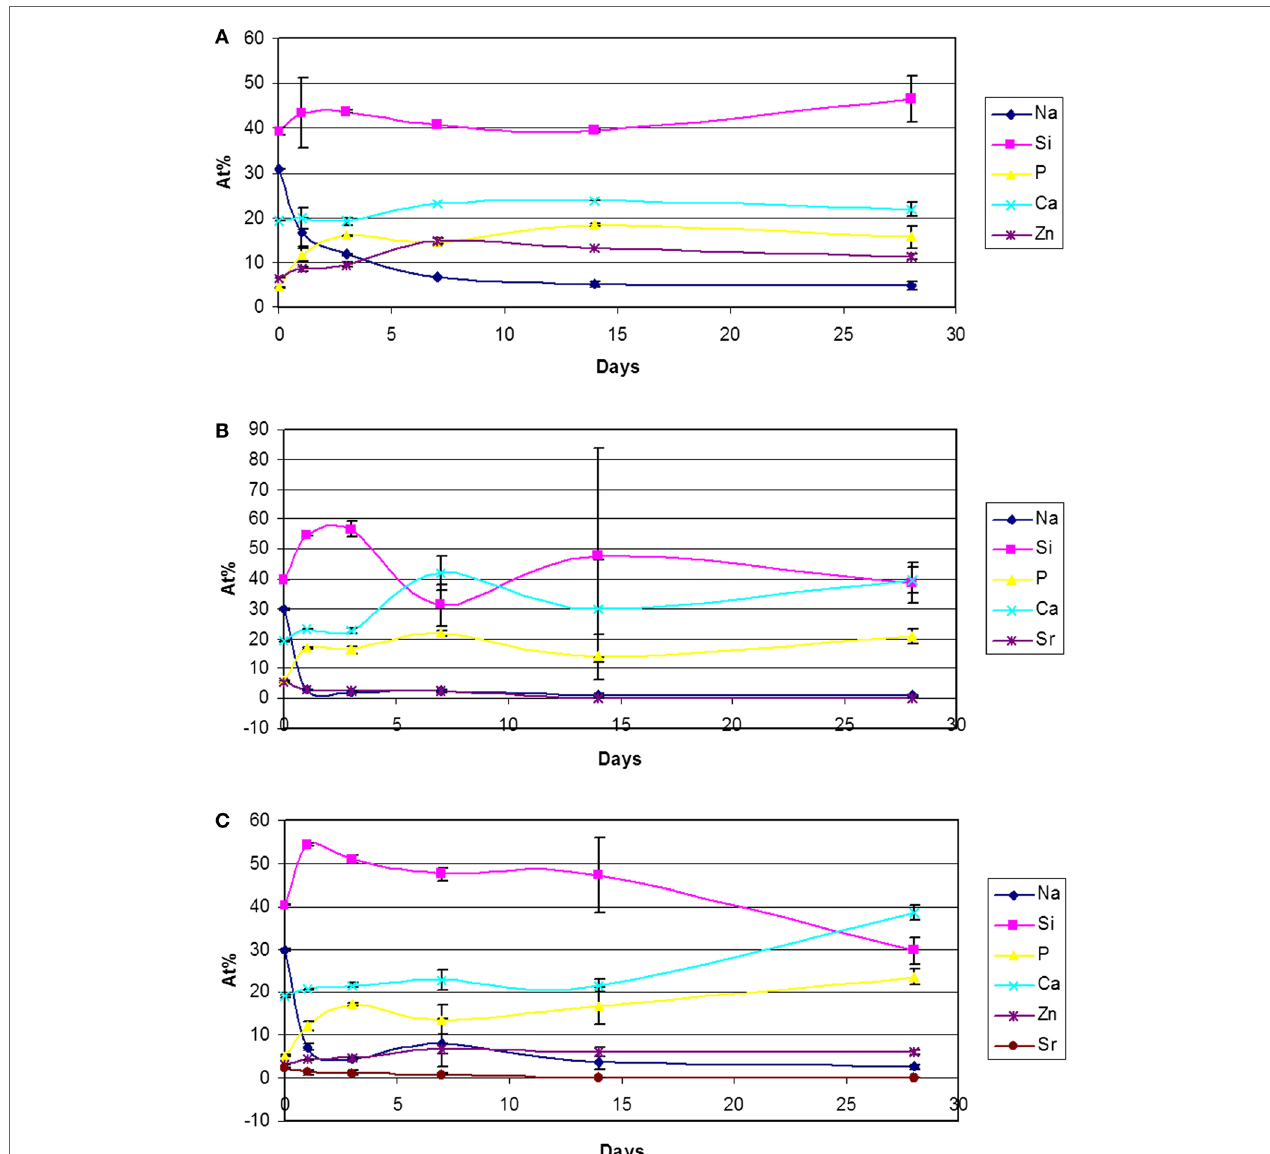
FigUre 4 | atomic percentages variation (eDs analyses of 500 × area) of 45s5-Zn (a), 45s5-sr (B), and 45s5-Znsr (c) after immersion in sBF